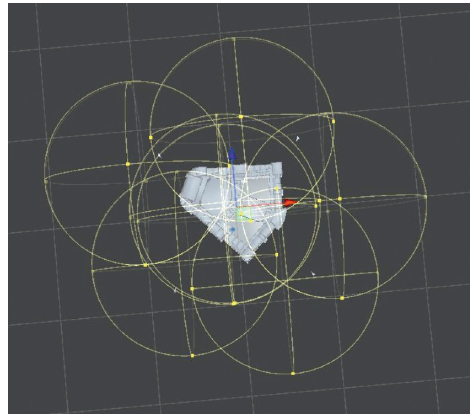
Fig. 8. Arrangement of point lights on the scene, top